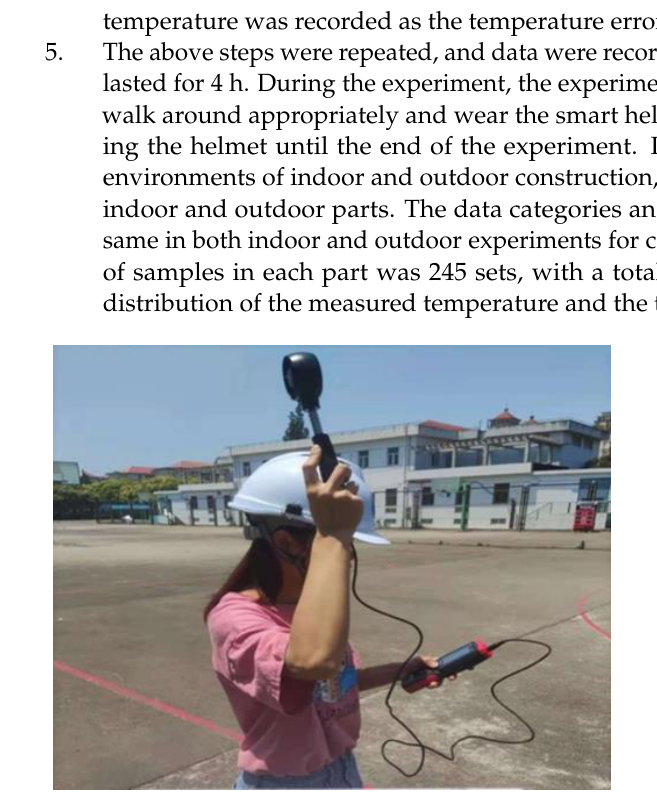
Figure 4. Experimenters measuring wind speed.